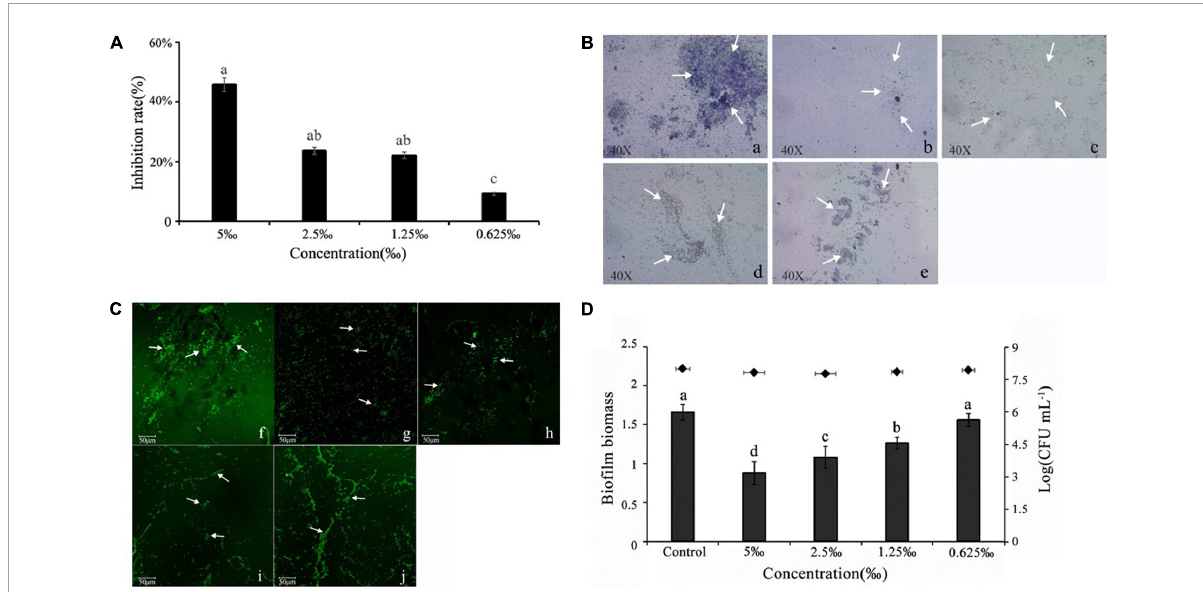
FIGURE3 Methyleugenol (ME)-reduced biofilm formation of Chomobacterium violaceum . (A) Quantitative assessment of biofilm biomass inhibition, (B) light microscopic images (a–e) , under a light microscope at a magnification of 40 × , and (C) confocal laser scanning microscopy (CLSM) (f–J) . Images of untreated and ME-treated biofilm of C. violaceum , (a,f) untreated; (b,g) 5 . (D) Effect of ME on performed biofilm. The arrows are the dyed biofilm. Mean values of eight times independent experiments and SD were shown. Significant at P <